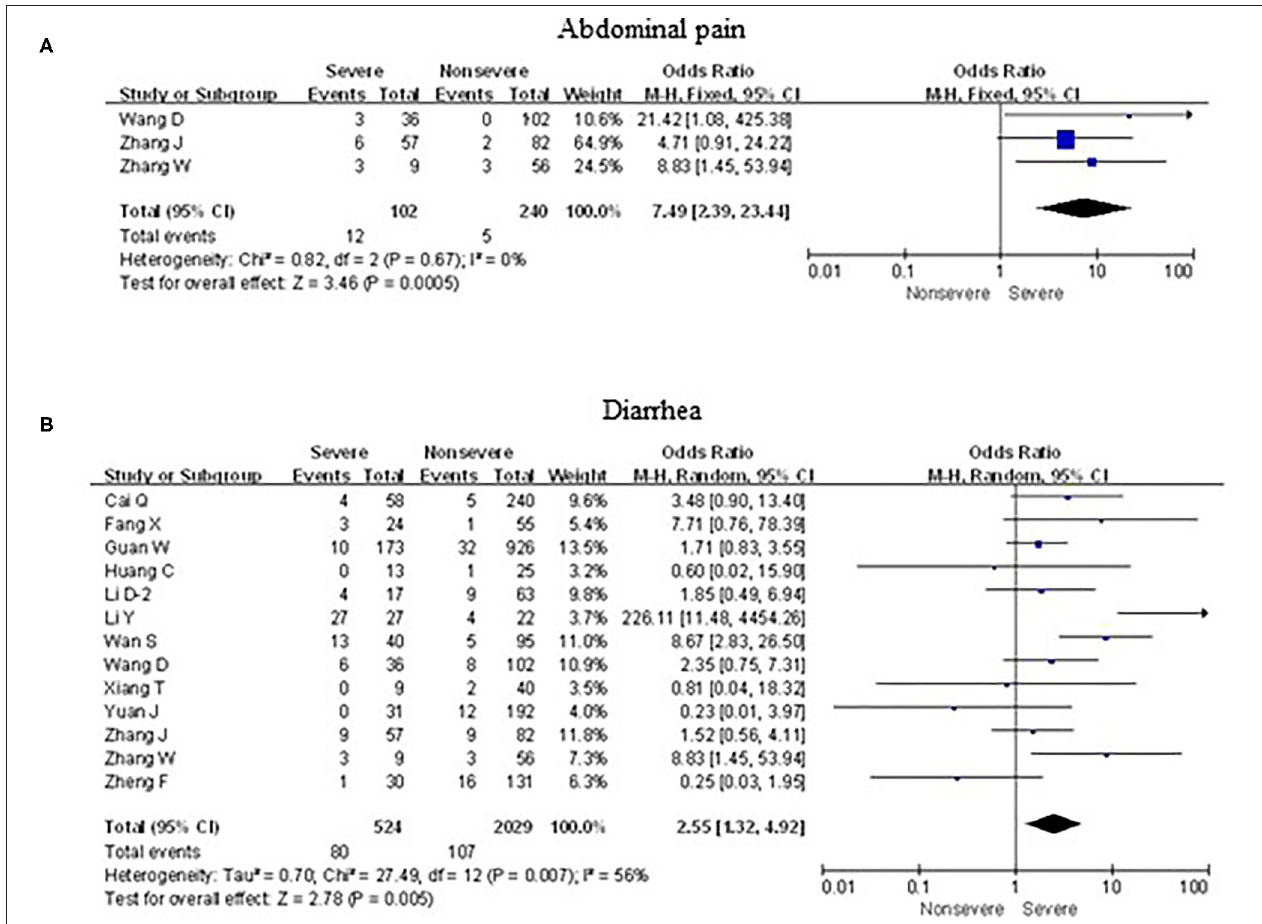
FIGURE 7 | Forest plots of odds ratios (ORs) showed the associations between digestive symptoms, including abdominal pain (A) as well as diarrhea (B) , and disease progression of COVID-19